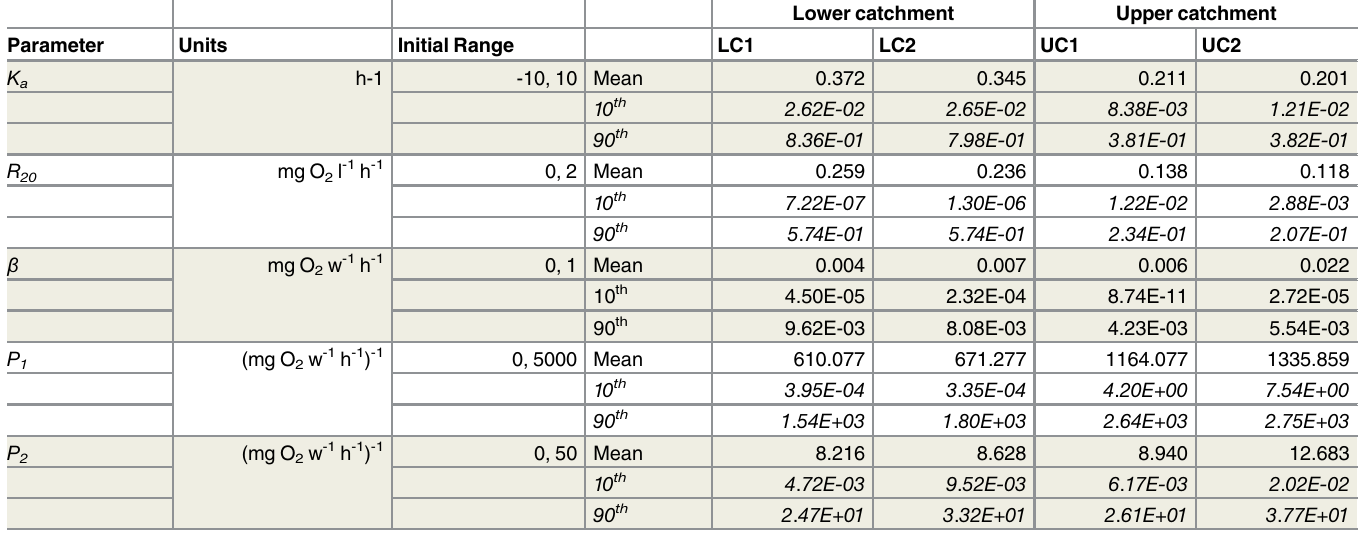
Table 2. Parameter comparisons between upper catchment site and lower catchment site. K a = Reaeration coefficient, R 20 = Respiration rate, β = Pho- torespiration parameter, P 1 = Linear photosynthesis parameter, P 2 = Light saturation